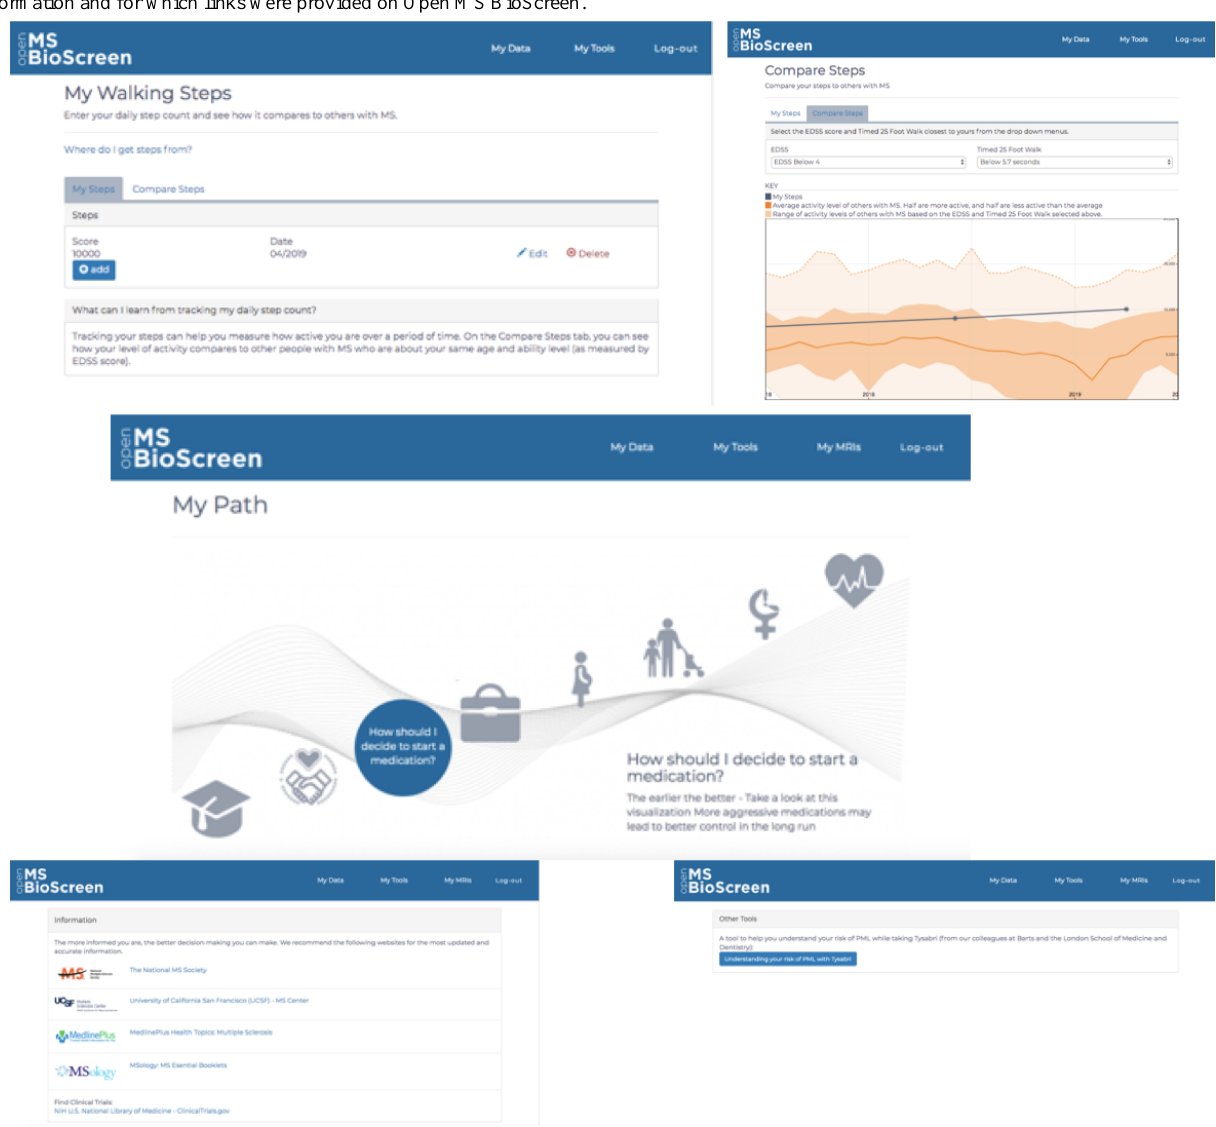
Figure 5. Additional features developed after the Open MS BioScreen live data. The top panel depicts the step count comparison tool that allows patients to enter their daily step count and compare this with others from a cohort of patients with multiple sclerosis (MS) at their phase of the disease [35]. The middle panel depicts My MS Paths, a visualization narrating specific decisions and challenges that patients may face over their lifetime living with MS. The bottom panel shows links to algorithms and clinical decision support tools developed by other investigators that provided complementary information and for which links were provided on Open MS